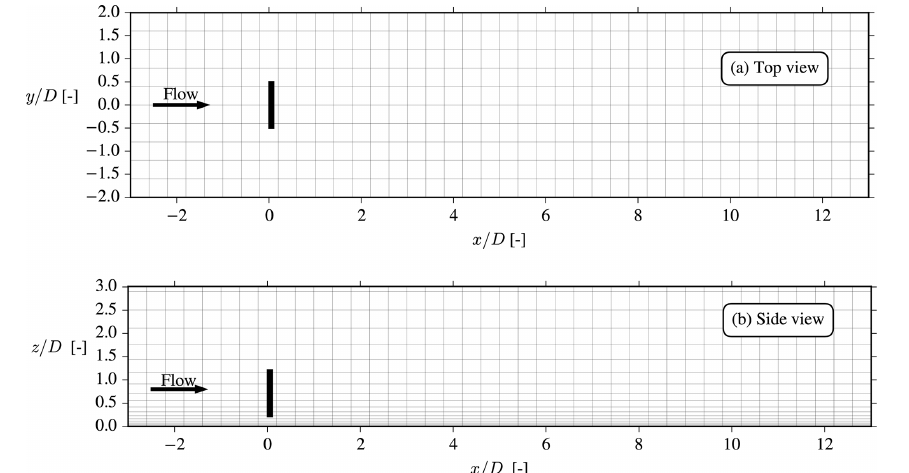
Figure 3. Top and side views of the wake domain, the size of which is { l x ,l y ,l z } /D = { 16 , 4 , 3 } . The total grid size is { L x ,L y ,L z } = { l x + 2 x + 2 x + 22 D } and is too large to be shown here because x in ,l y in ,l z